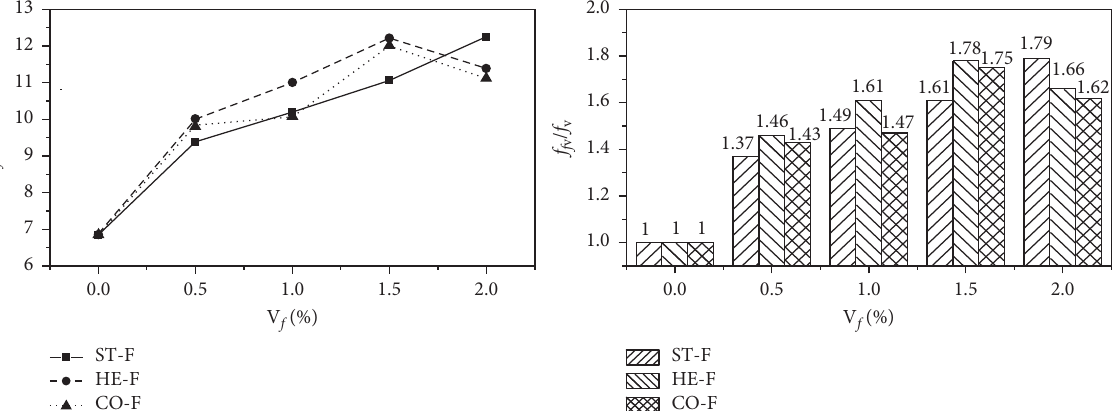
Figure 6: Relationship between f